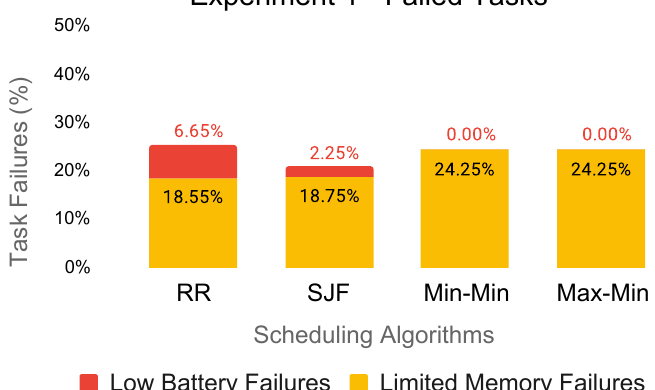
Figure 4. Percentage of failed tasks for Experiment 1 (2000 tasks).